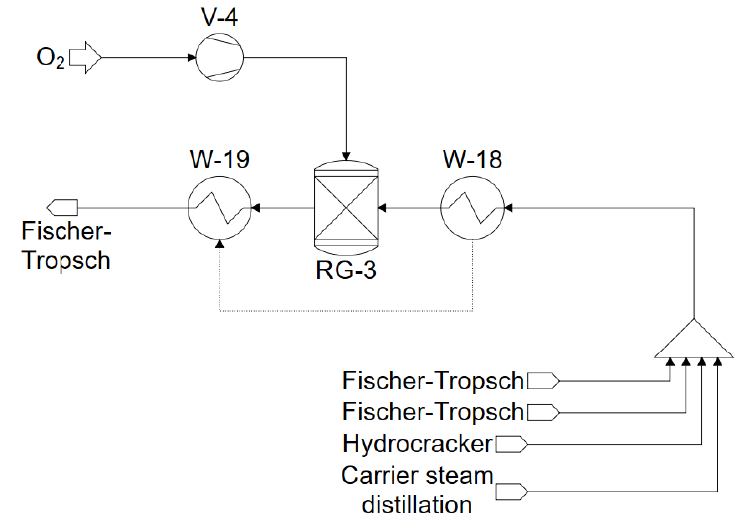
Figure 7. Excerpt from the process flow diagram: reformer.